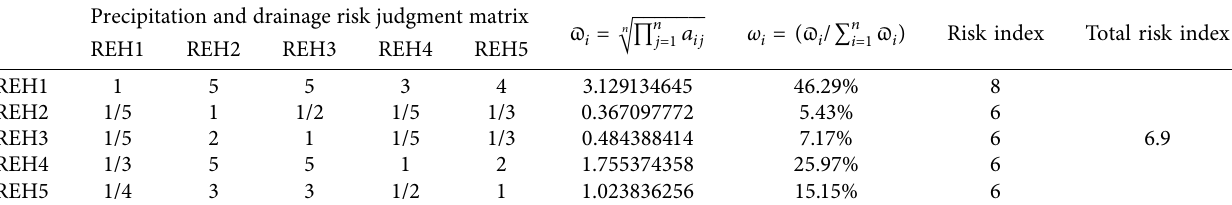
Table 26: Precipitation and drainage risk judgment matrix.